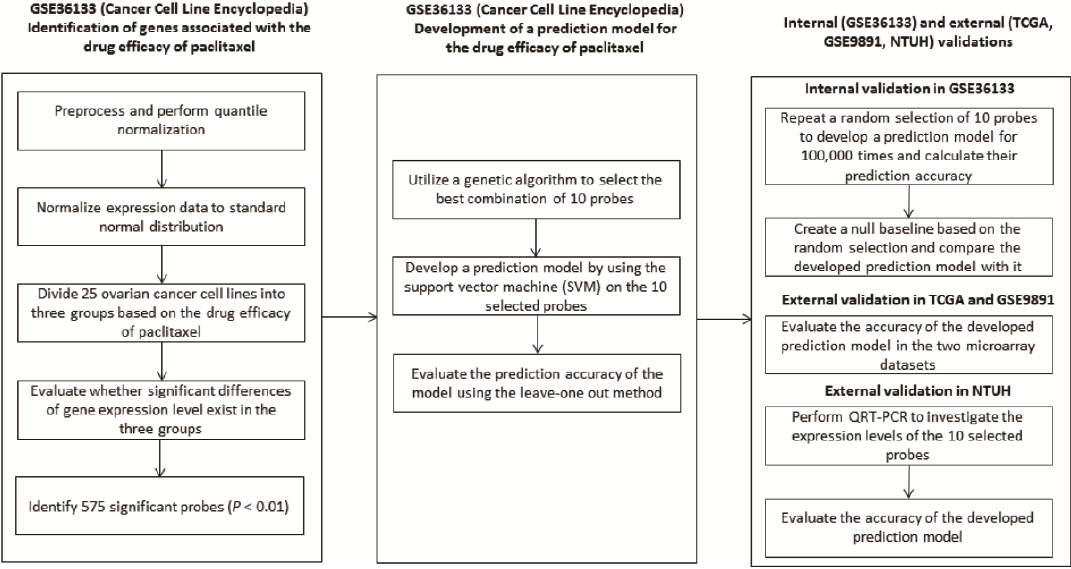
Figure 1. The overall protocol utilized in this study to develop the predictive model.